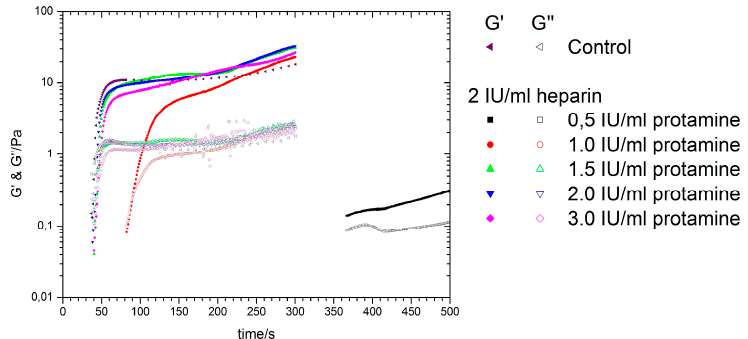
Figure 4. Back titration of heparin with protamine. Citrated blood was heparinised (2.0 IU/mL) and simultaneously antagonised with various concentrations of protamine before activation with Thromborel. Citrated blood without heparin activated by Thromborel served as control. The effect of the inhibitor heparin was reversed by various concentrations of protamine (1.5–3.0 IU/mL). Both, 0.5 and 1.0 IU/mL protamine were too weak to reverse the effect of heparin. The lowest protamine concentration of 0.5 IU/mL has a strongly delayed clotting time (CT), a flatter slope and a lower elastic and viscous shear moduli compared to the other